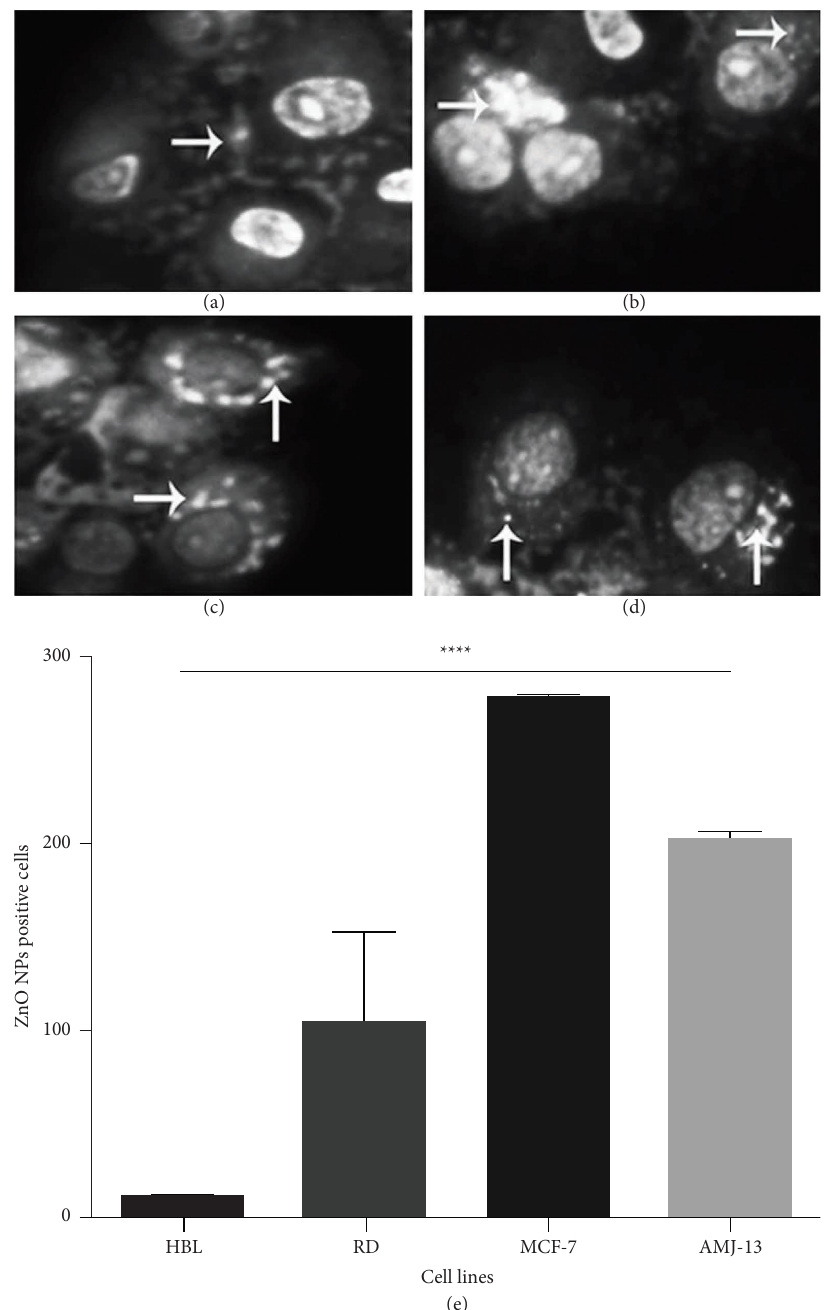
Figure 3: Morphological investigation of treated tumor and normal cells. (a) Te normal cells of the breast did not accumulate ZnO NPs in treated cells. ZnO NPs internalized and aggregated within most tumor cells as illustrated (white arrow) from 1h to 3.30h in cells (b, c, d) RD, MCF7, and AMJ13. (e) Te quantifed data reveal a substantial diference in the concentration of ZnO NPs within tumor cells versus normal